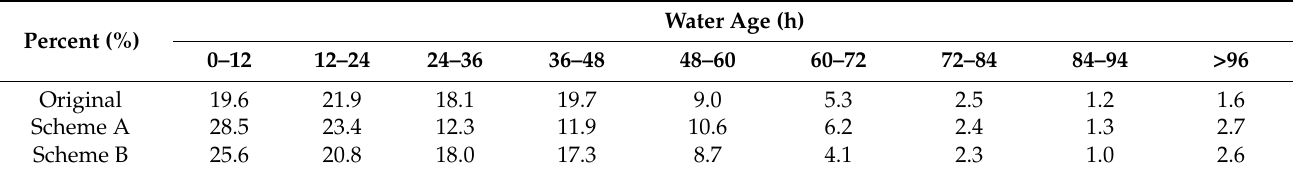
Figure 4. Water proportion statistics of each age period in the three scenarios.